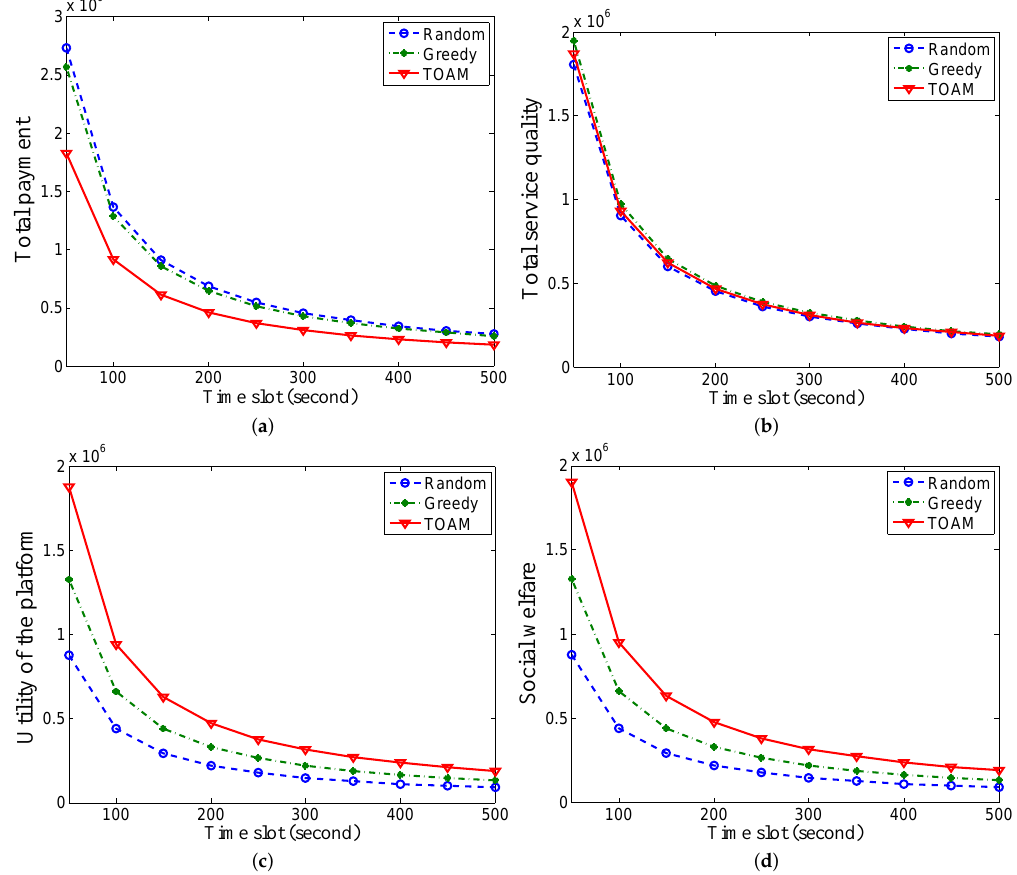
Figure 3. Performance comparisons under the Dartmouth dataset with 100 users. ( a ) Comparison of average payment; ( b ) Comparison of average service quality; ( c ) Comparison of the average utility of the platform; ( d ) Comparison of average social